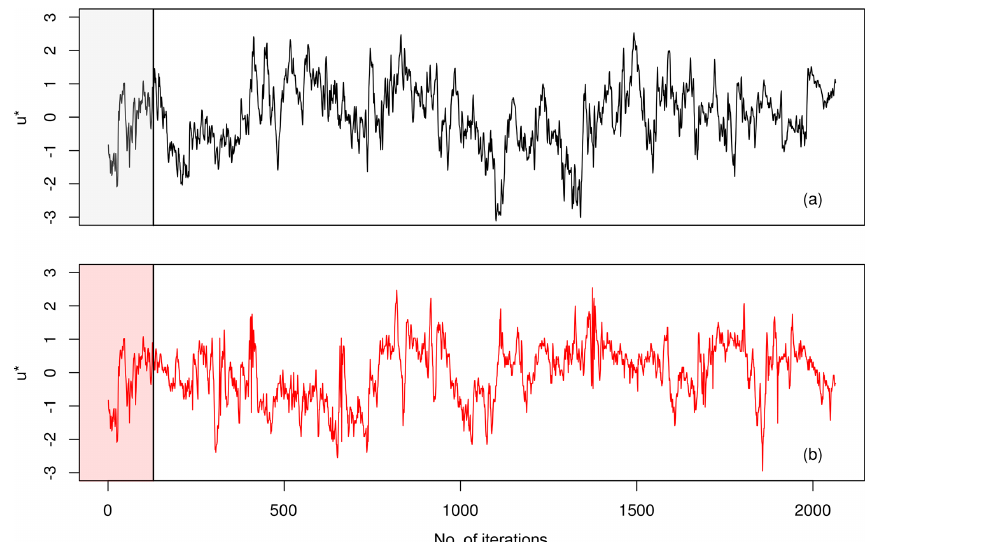
Figure 6. Comparison of original wind speed time series u ∗ (black, a ) with the reconstructed one using Eq. (8) (red, b ). The vertical line marks the transition from the N = 128 starting values to the simulated wind